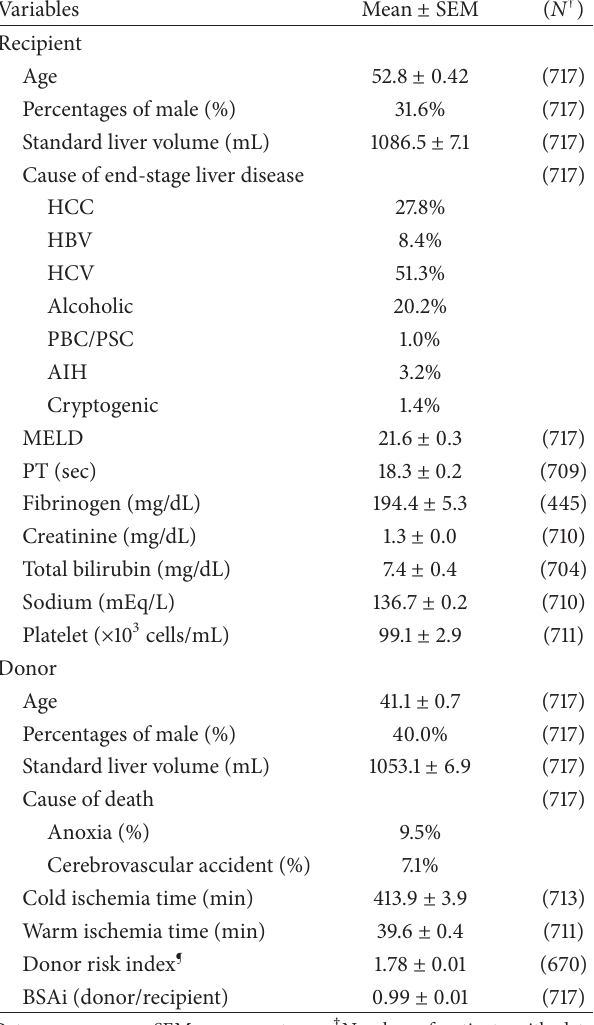
Table 1: Recipient and donor variables.